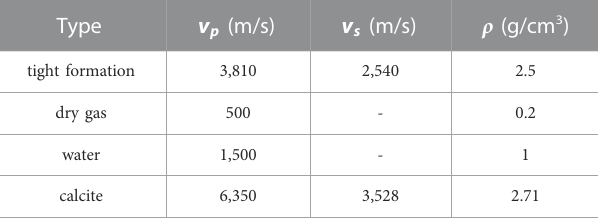
Figure 1 is a schematic diagram of three-dimensional model of an in fi nite extent fracture intersected with horizontal well in tight formation. The well is fi lled with water. The dimensions of the model in X , Y and Z directions is 4, 2 and 7 m respectively. The radius of the well bore is 0.1 m. The well bore axis coincides with the Z -axis. The sound source and receivers are positioned along the well axis. The sound source is located at X=0, Y=0, Z=0. The minimum distance between the receiver and the sound source is 1.05 m, and 35 receivers are placed continuously at an interval of 0.15 m. The fracture plane is parallel to the Y -axis and extends in fi nitely after passing through the well bore. The intersection point of the fracture and the well axis is at X=0, Y=0, Z=4.5 m. The width, dip angle and the fi lling medium of the fracture are variable. The formation where the fracture and well bore are located is elastic. Table 1 shows the physical parameters of the elastic tight formation and the fracture fi lling medium (dry gas, water, calcite). In the fi nite difference method, the space step Δ x , Δ y and Δ z is 5 mm. borehole, we select the Ricker wavelet source with the dominant frequency of 10 kHz to study the response of the monopole P wave, and the narrow-band cosine envelope source with the dominant frequency of 3.5 kHz to study the response of the dipole S wave. The sound source waveform and amplitude spectrum are shown in Figure 2.